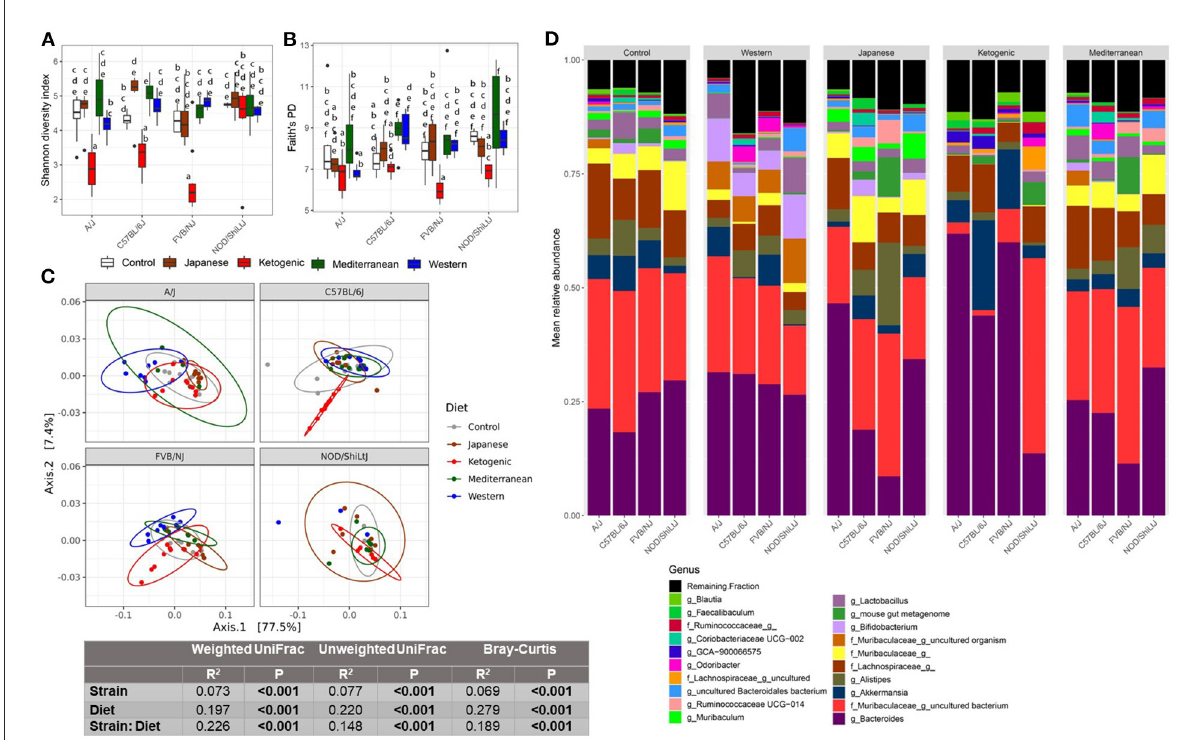
FIGURE1 Diet-gene interaction on gut microbiota. Shannon diversity index (A) and Faith’s PD (B) α -diversity by diet and strain. Boxes without a common letter are significantly ( p < 0.05) different from others. Boxes with common letters represent no significant difference. 2-way ANOVA with Tukey’s post hoc analysis was performed to determine the statistical differences. (C) Weighted UniFrac β -diversity PCoA plot. The color of the point represents diet. The ellipse on the principal coordinate analysis plot indicates 95% CI of the clusters by groups. Inset box is the results of ADONIS test on diet, strain, and their interaction. ADONIS analyses were adjusted for sex as a covariate. (D) Mean relative abundance of top 20 genera in A/J, C57BL/6J, FVB/NJ, and NOD/ShiLtJ mice treated with control mouse diet, WD, JD, KD, or